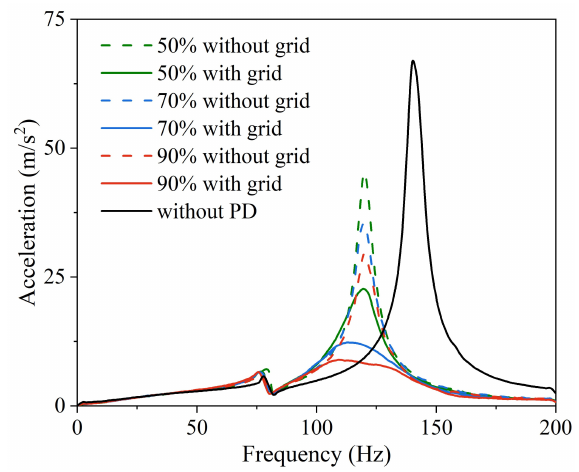
Figure 3. Vibration response of cantilever beam with and without obstacle grid particle dampers .